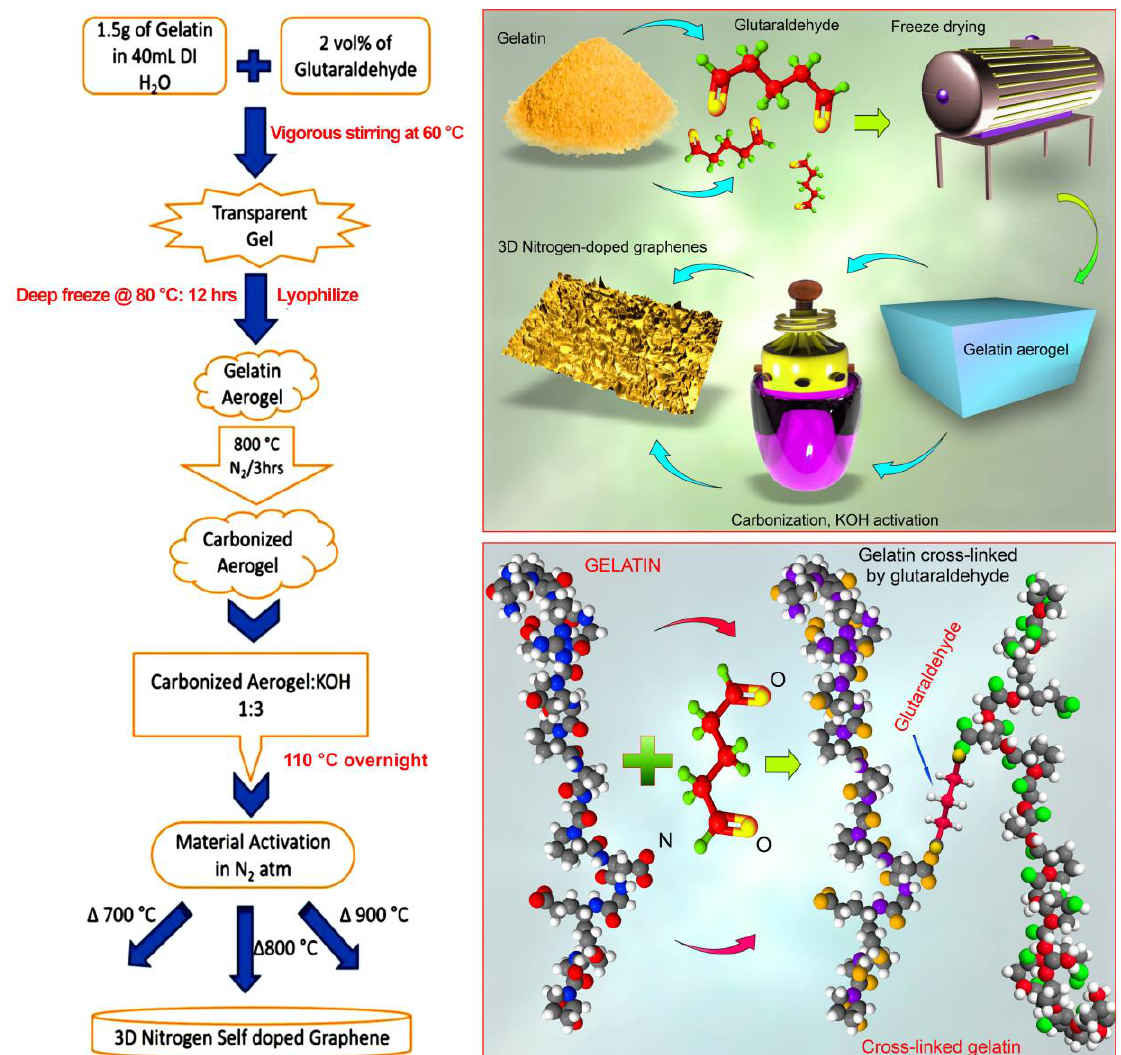
Figure 1. Step-by-step synthesis of 3D nitrogen self-doped graphene-based carbon aerogels involves the cross linking of gelatin and glutaraldehyde, followed by the deep freezing of the gel (shown in the bottom right image). Top right image shows an overall experimental approach.